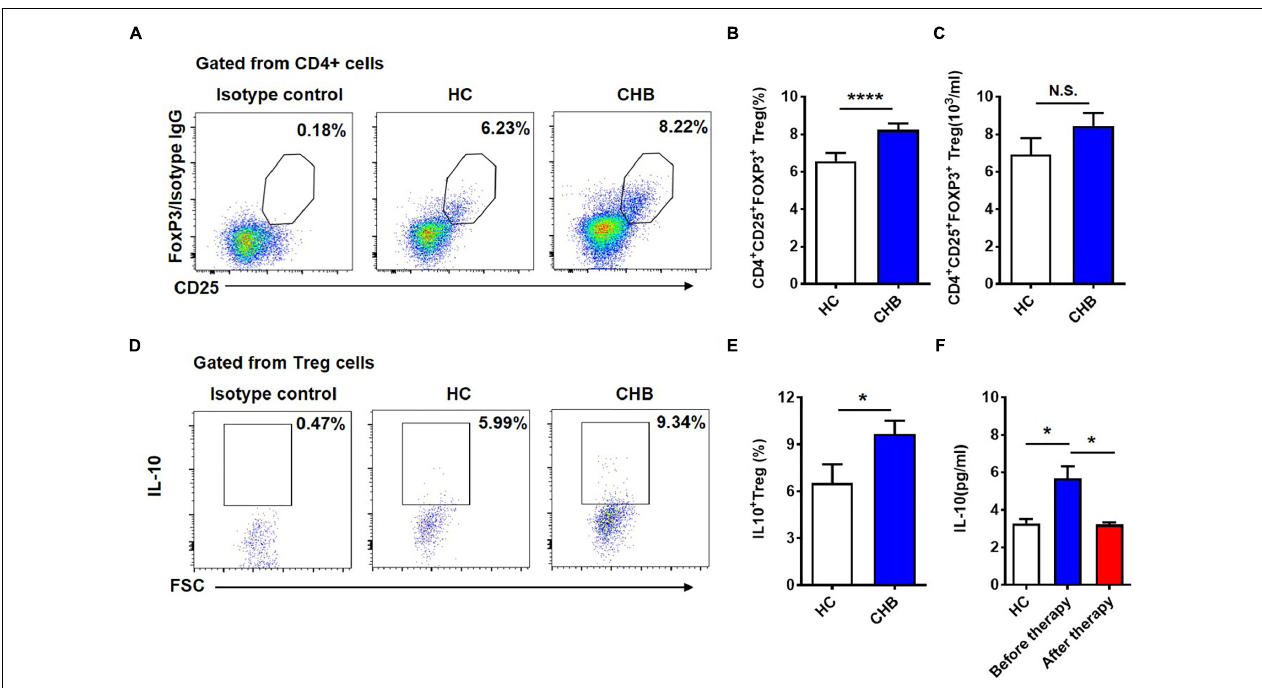
FIGURE 4 | Circulating Tregs and secreted IL-10 in patients with CHB infection. (A) Representative flow cytometry plots showing CD4 + CD25 + FOXP3 + Tregs in peripheral blood samples from patients with CHB and healthy controls. (B) Data from (A) were compiled and analyzed for significance using the t -test. (C) Comparison of the absolutely numbers of CD4 + CD25 + FOXP3 + Tregs in peripheral blood samples from patients with CHB and healthy controls. (D) Representative flow cytometry plots of IL-10 + Tregs in peripheral blood samples from patients with CHB and healthy controls. (E) Data from (D) were compiled and analyzed for significance using the t -test. (F) Comparison of serum IL-10 levels detected using a CBA kit in healthy controls, and patients with CHB patients before and after antiviral treatment. Data are representative of more than three independent experiments. Results are presented as the mean ± SEM ( n ≥ 3 per group) and unpaired two-tailed Student’s t -tests and one-way ANOVA were conducted; * p < 0.05, **** p < 0.0001. N.S., not